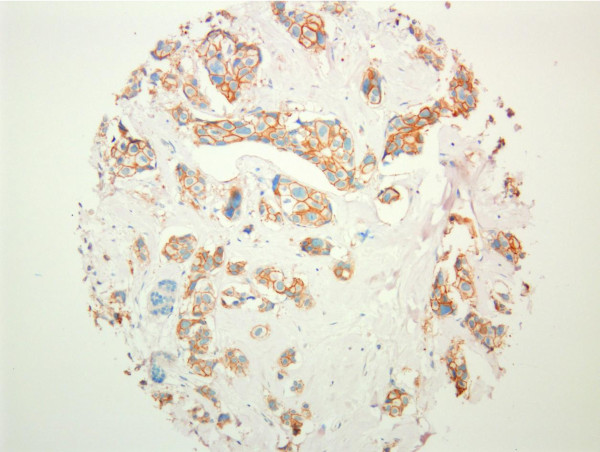
TMA core displaying weak membranous HER2 staining (2+, 4B5 antibody). HER2, human epidermal growth factor receptor 2; TMA, tissue micro-array.